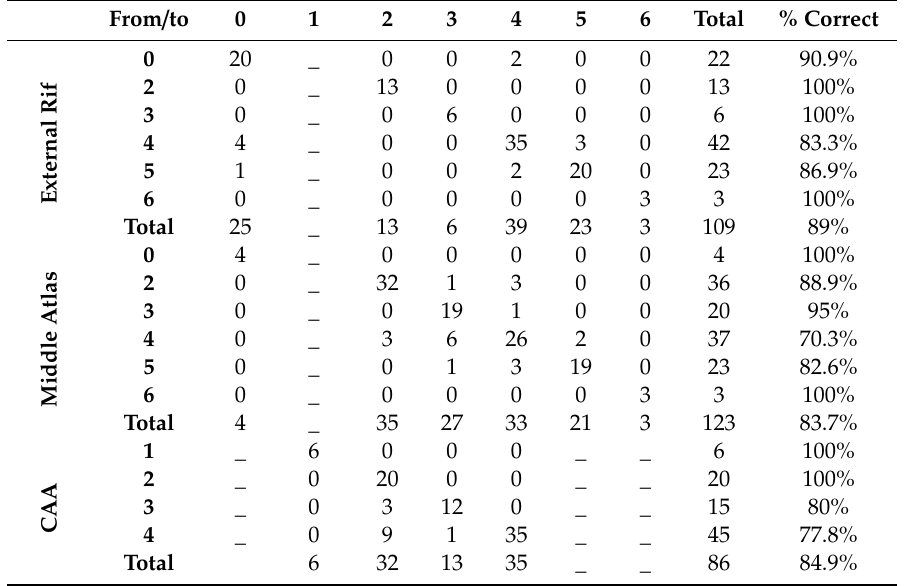
Table 6. Confusion matrix of the discriminant analysis for each sector. (Dendritic = 0, pinnate = 1, parallel = 2, trellis = 3, rectangular = 4, herringbone = 5 and barbed = 6).